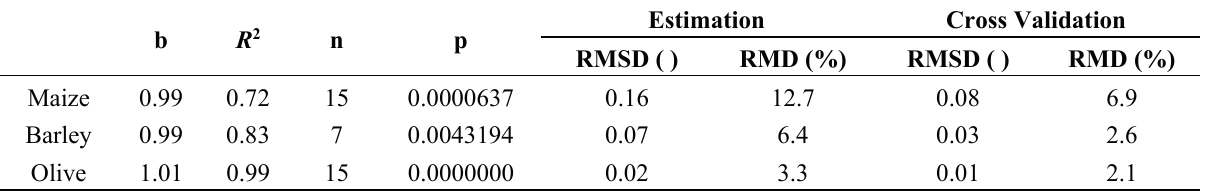
Table 7. Statistical indicators relative to the comparison between actual K c VI and K c SIMDualKc . b R 2 n